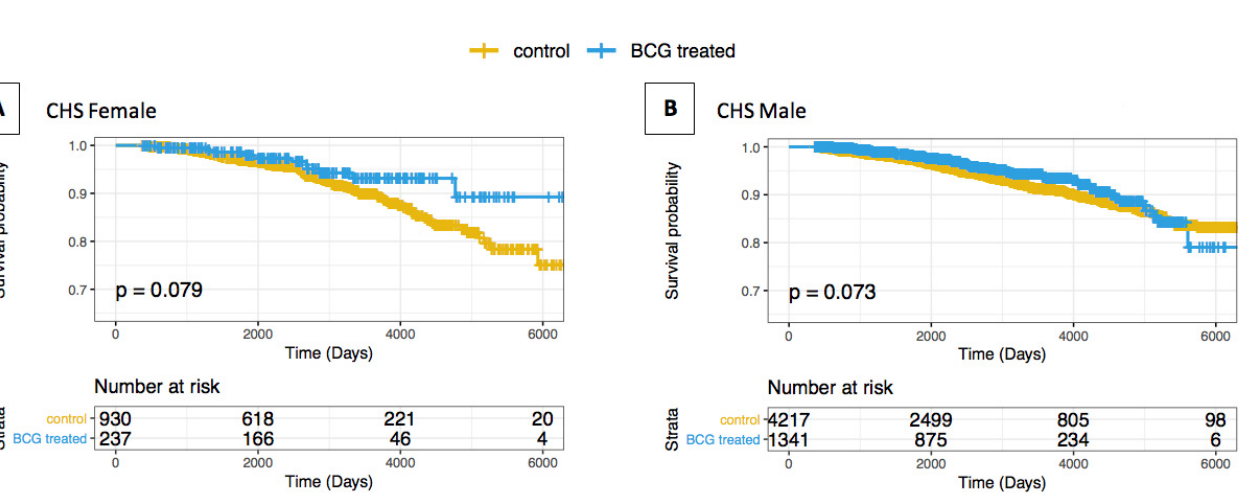
Figure 2. Kaplan–Meier survival curves of bladder cancer patients treated or not treated with BCG by gender. The whiskers on the Kaplan–Meier (KM) survival plots represent the censored patients. ( A ) CHS female AD-free cohort; ( B ) CHS male AD-free cohort.